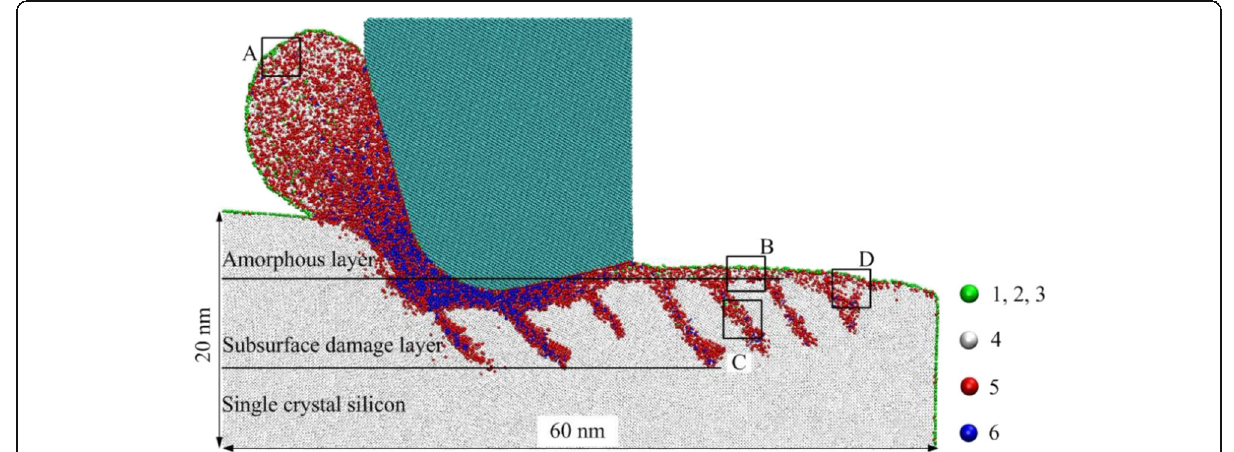
Fig. 2 Sectional view on the (100)[0 – 10] crystal direction at a cutting distance of 50